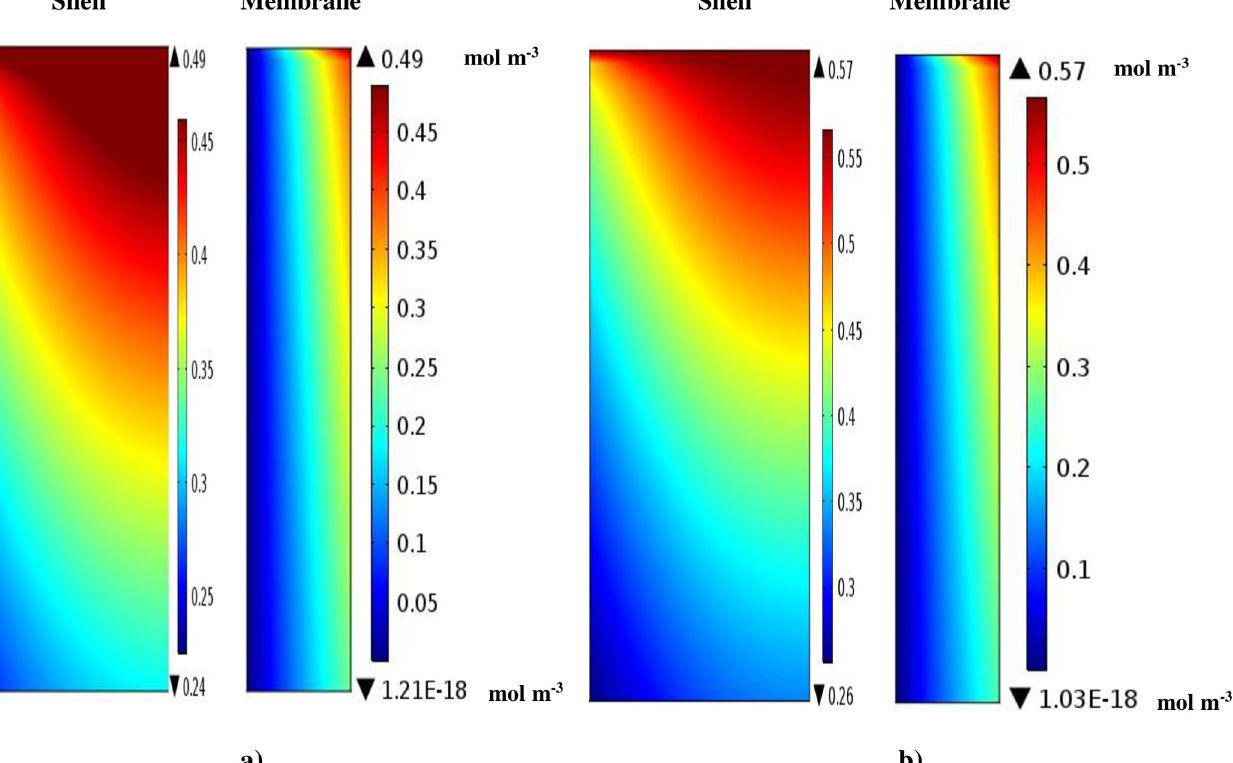
PLOS ONE | https://doi.org/10.1371/journal.pone.0237271 August 31,